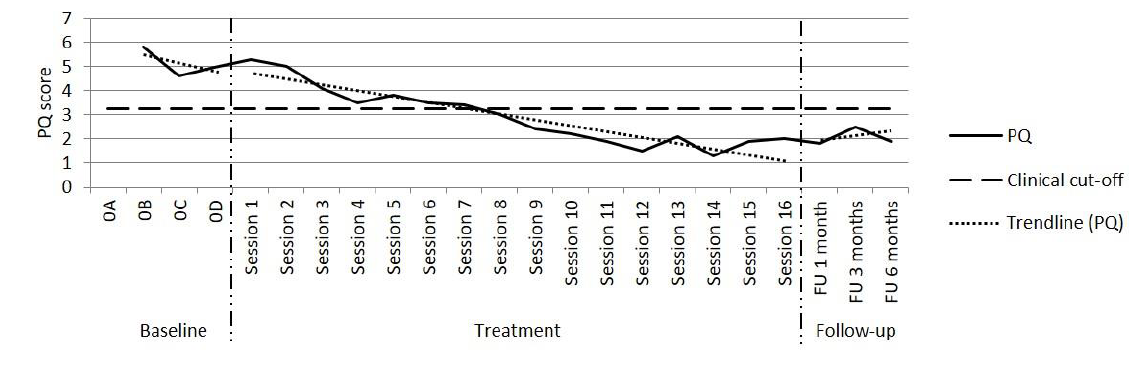
Figure 4: Margherita’s weekly personal problems (PQ)